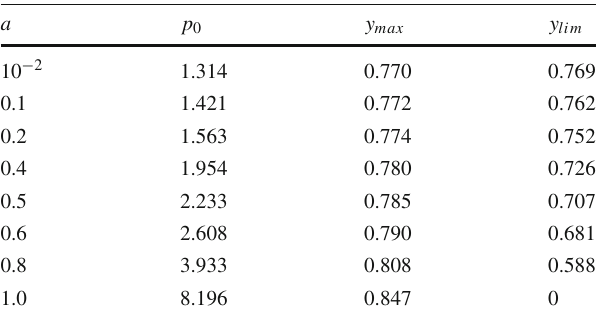
Table 2 Critical values of p denoted as p crit , obeying y ( p crit ) = 1, and q crit corresponding to p crit according to Eq. (94) for certain values of a (1 < a ≤